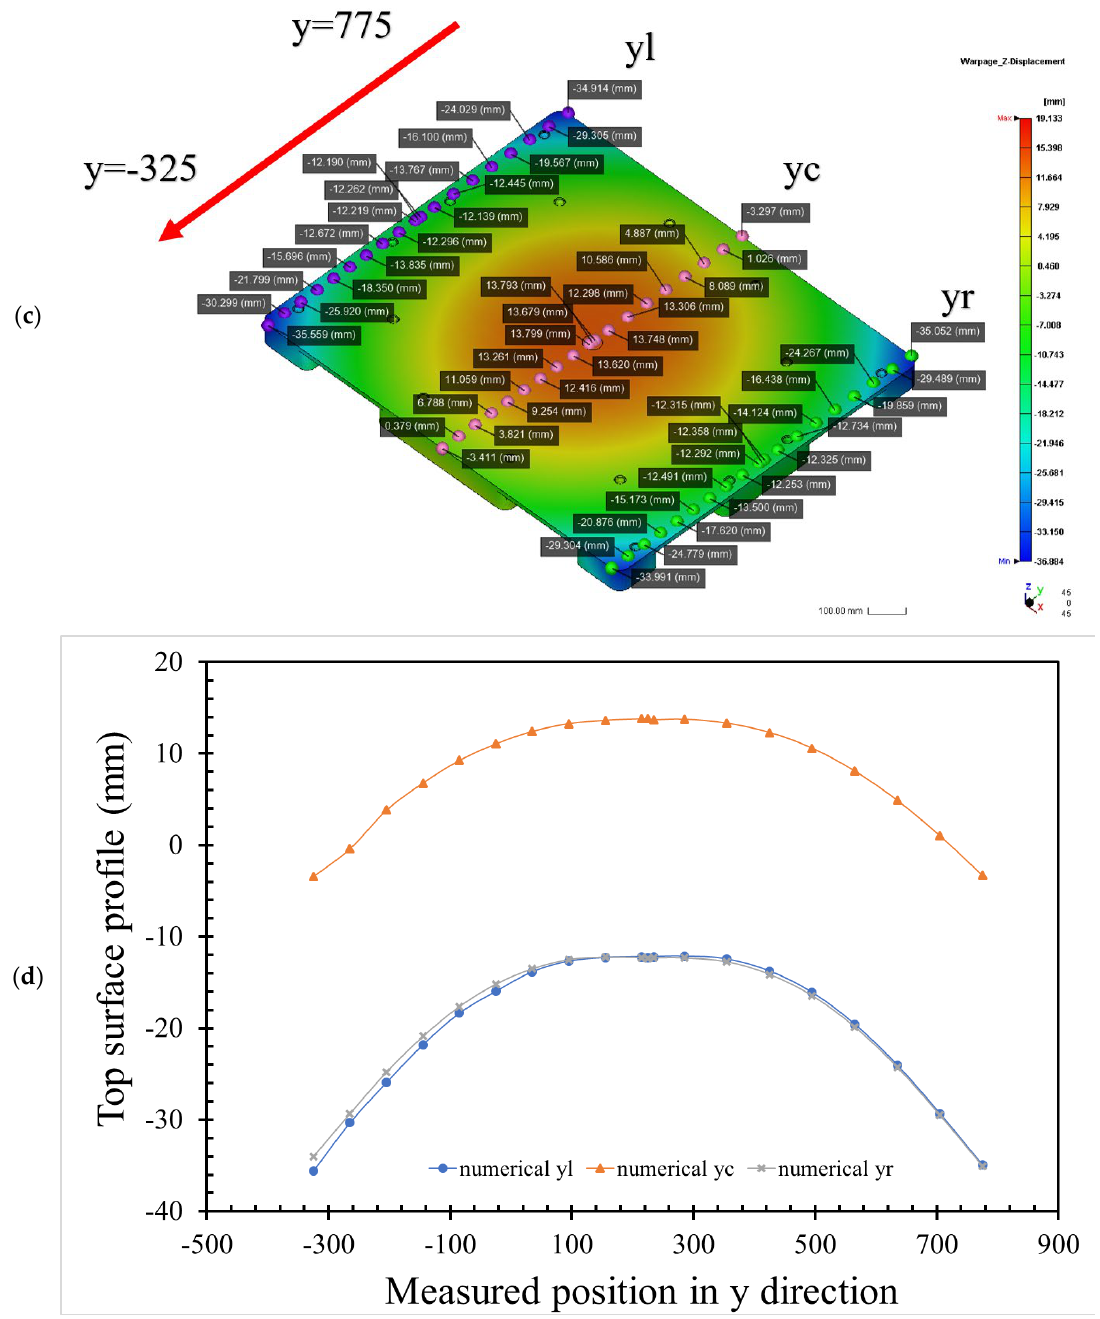
Figure 5. Top profiles in the height direction of the numerical warpage of an HDPE half-pallet by pre-setting ICM parameters: ( a ) isometric view of the numerical top flatness of the half-pallet along the x-axial direction; ( b ) x-axial top surface profiles; ( c ) isometric view of the numerical top flatness of the half-pallet along the y-axial direction; ( d ) y-axial top surface profiles.